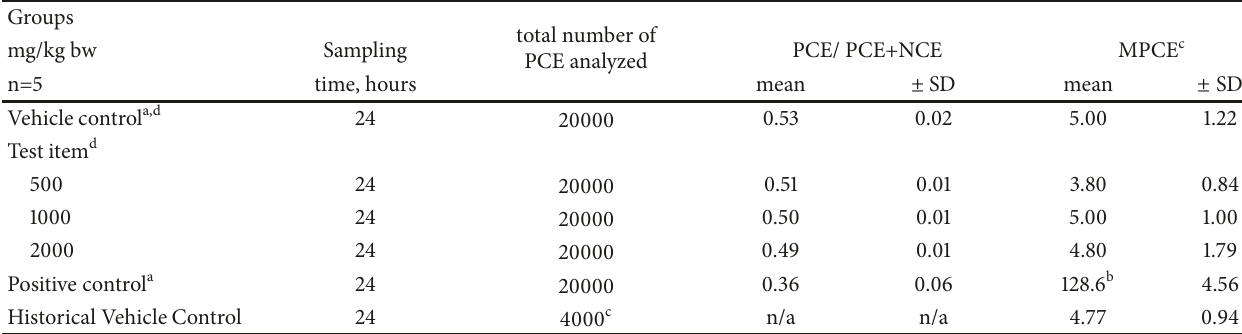
Table 4: Summary of mouse micronucleus test